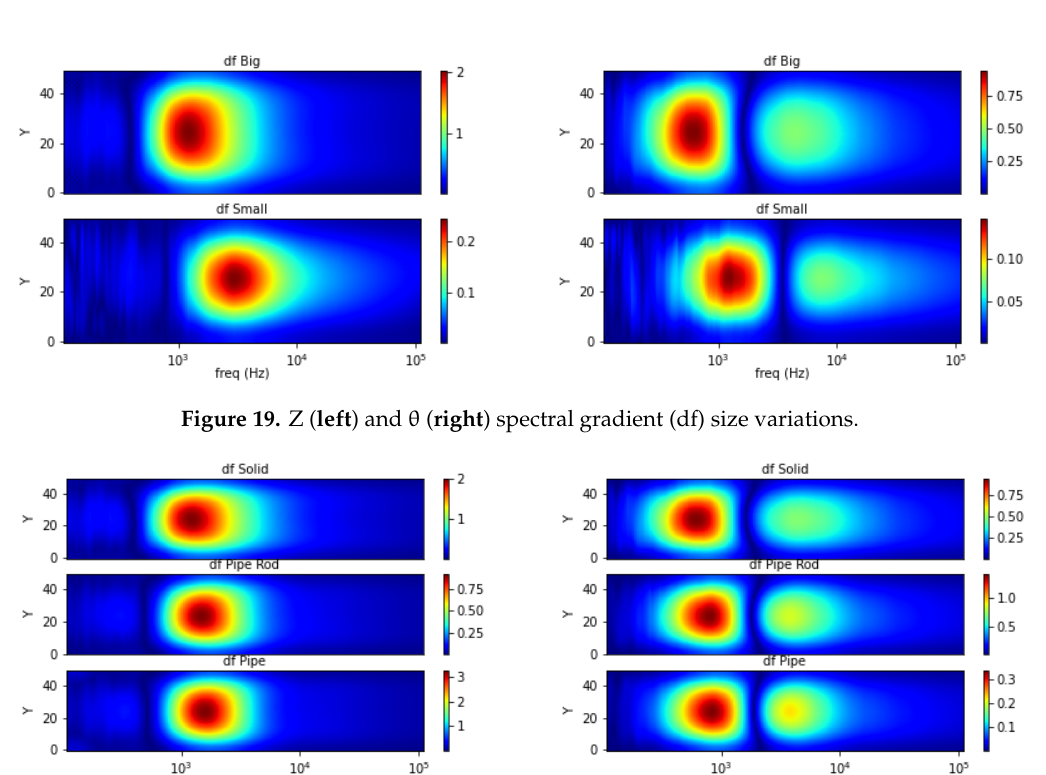
Figure 20. Z ( left ) and θ ( right ) spectral gradient (df) metallic structures.